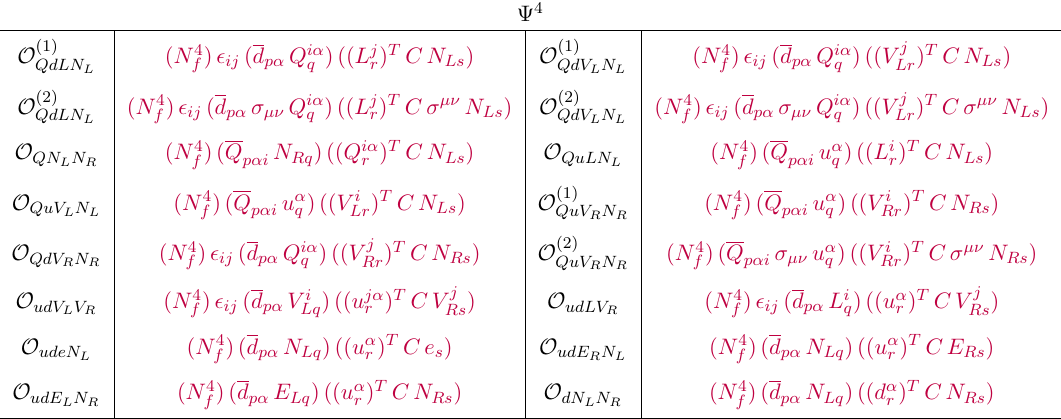
Table 16 . SM extended by Vector-like Leptons ( V L,R , E L,R , N L,R ): additional operators of di- mension 6. i, j and α are the SU(2) and SU(3) indices respectively. p, q, r, s = 1 , 2 , · · · , N f are the flavour indices. All the operators violate only the lepton number (∆ B = 0 , ∆ L = − 2)